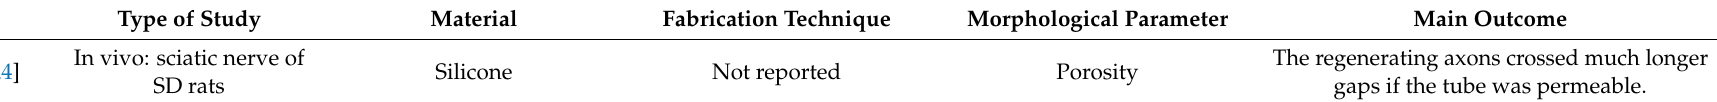
Table 3. Studies evaluating porosity, size and distribution of pores of